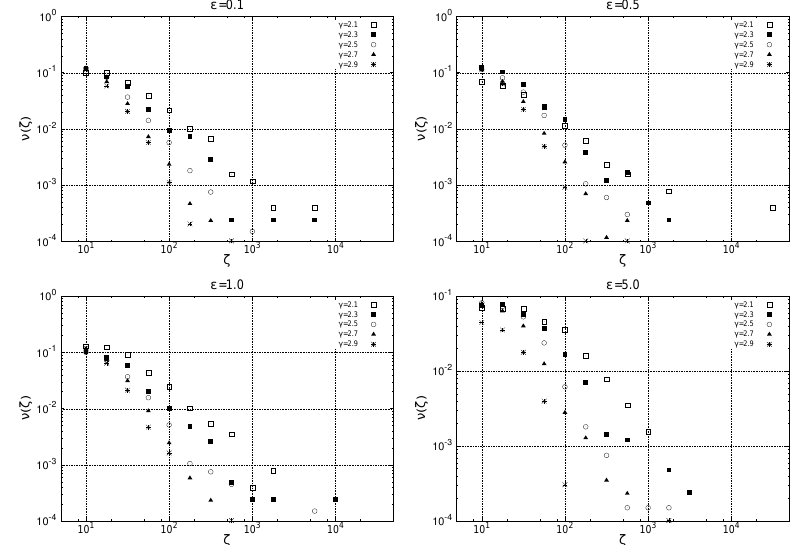
Figure 3. Distribution of relative frequencies ν of polarity intervals with the length ζ .